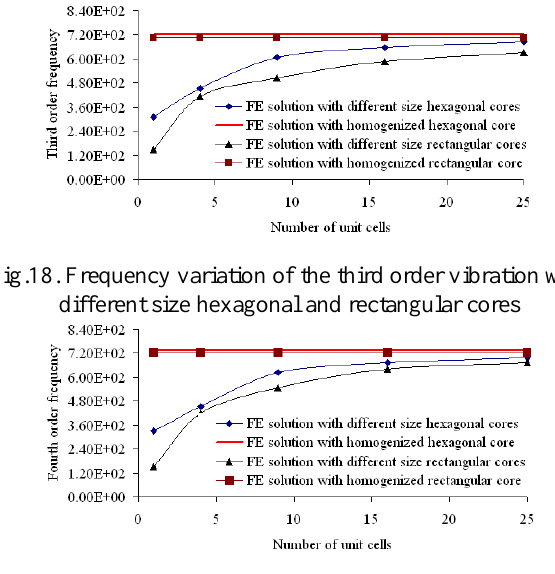
Fig.19. F with fferent ize hexag nal and rectangular ores